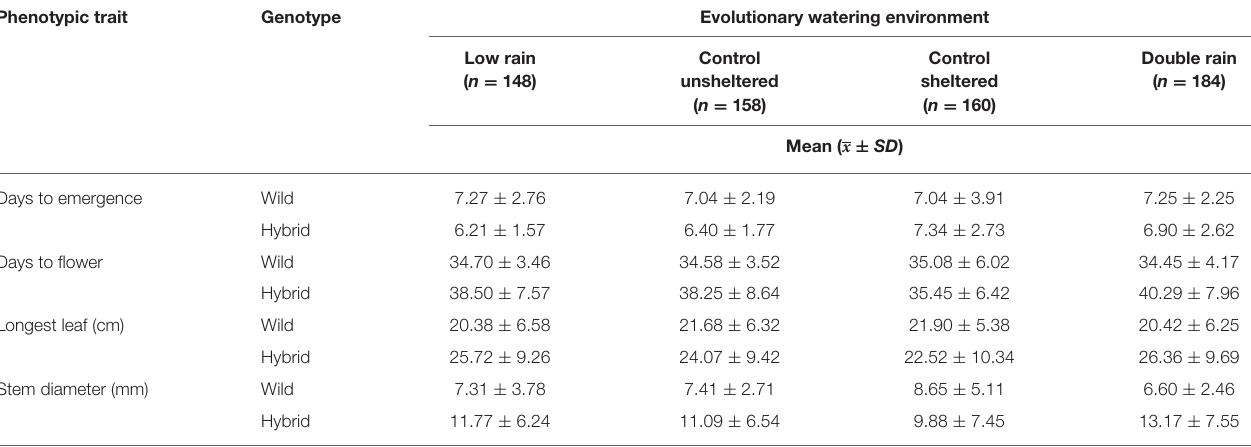
TABLE 3 | Mean phenotype values * of four traits across evolutionary watering environments for wild and hybrid radish plants. Phenotypic trait